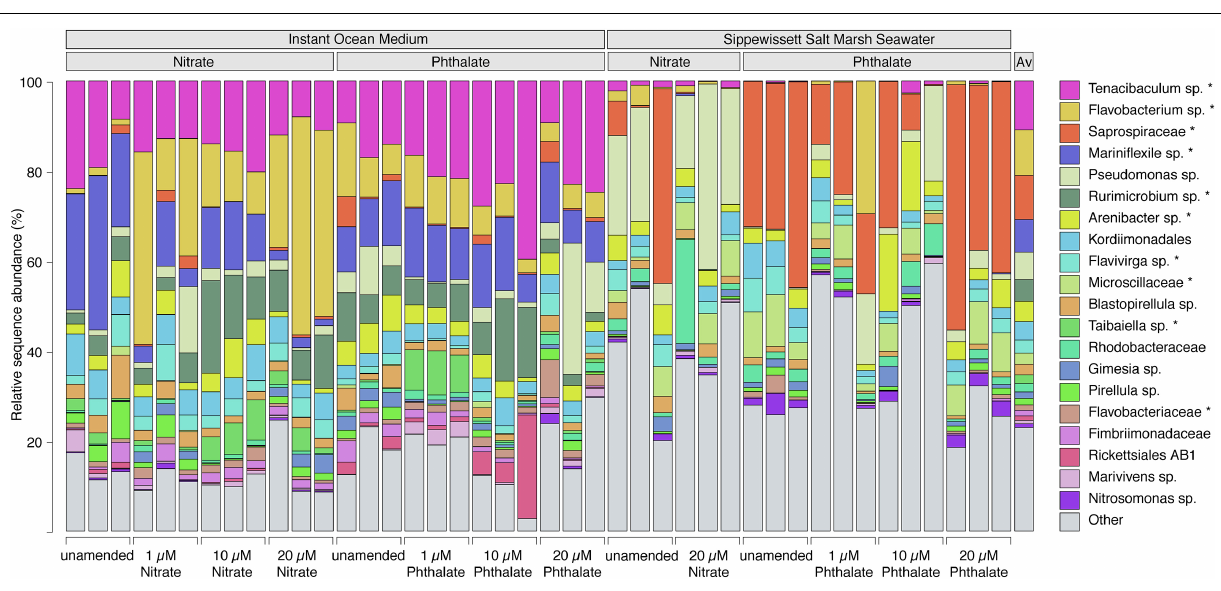
FIGURE 8 | Bacterial community composition of populations at species level. Each bar represents one sample and shows the 20 species-level lineages with the highest relative sequence abundance averaged across all datasets. All other lineages are summed up as “Other.” The average composition across all samples is shown in the last column. An unclassified population within the genus Flavobacterium (yellow) substantially increases with increasing nitrate concentrations. “Asterisk” denotes lineages that belong to the phylum Bacteroidia . Lineages that were not classified to genus level represent species in unclassified families (e.g., Saprospiraceae – red) or unclassified orders (e.g., Kordiimonadales – sky